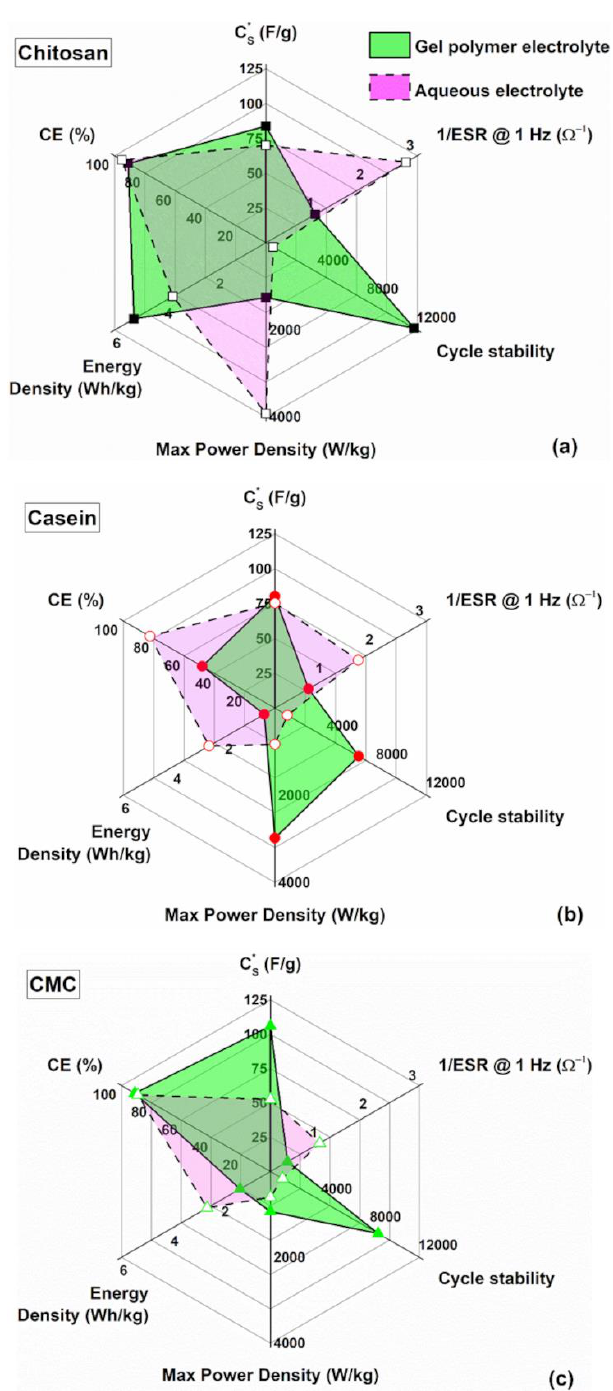
Figure 8. Radar plot to compare the performance of the supercapacitors based on gel polymer and reference liquid electrolytes with ( a ) chitosan, ( b ) casein and ( c ) CMC as an electrode